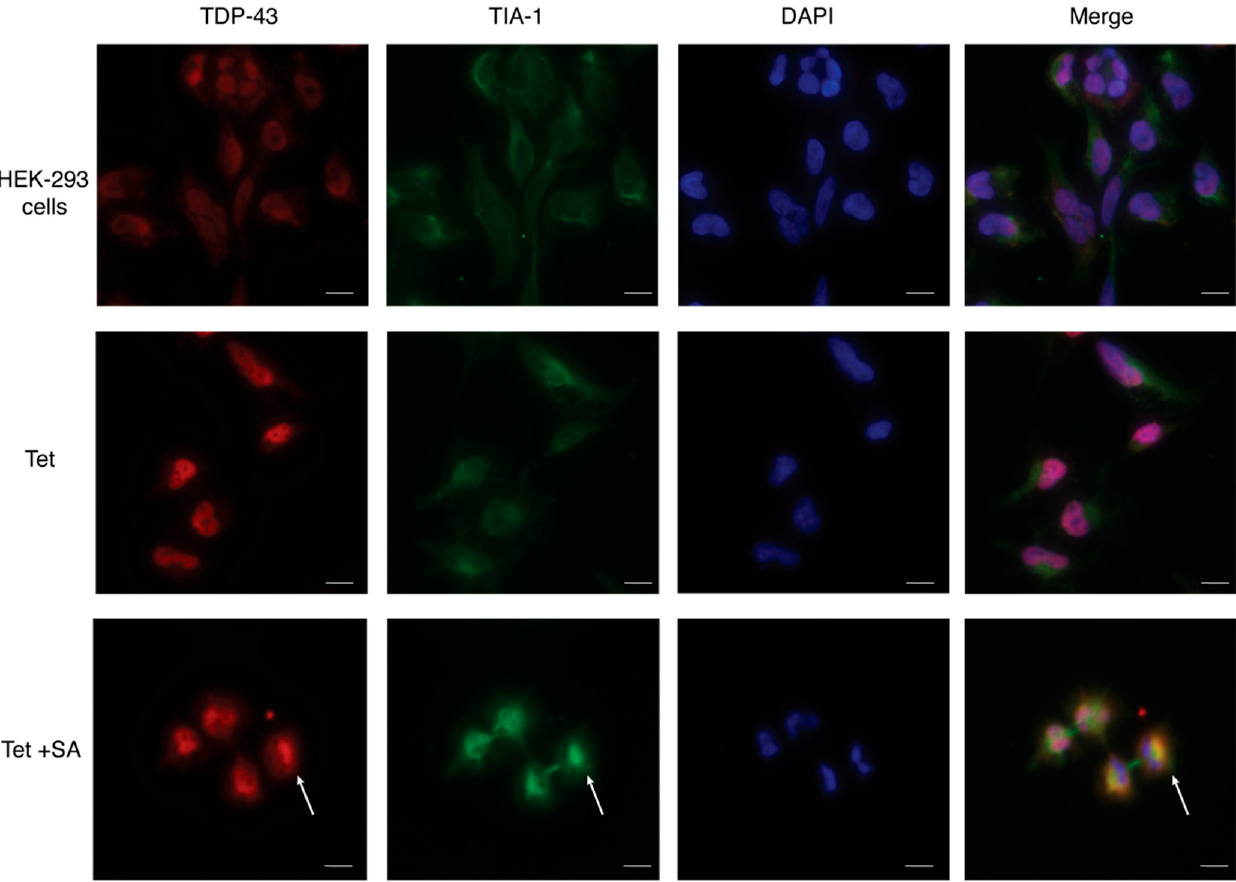
Figure 3. Immunofluorescence imaging of TDP-43 and TIA-1 in stably transfected HEK-293 cells. HEK-293 cells transfected with tetracycline (Tet)–inducible WT TDP-43 (2 ug/mL, 48 h) resulting in overexpression of TDP-43 (red), especially in the nucleus, but low levels of TIA-1. Sodium arsenite (15 µM, 18 h) treated cells displayed mislocalisation of TDP-43 which colocalised with upregulated TIA-1 (green) in the cytoplasm (white arrow). The nuclear stain DAPI (blue) was used to indicate the nucleus. Scale bar = 10 µM.